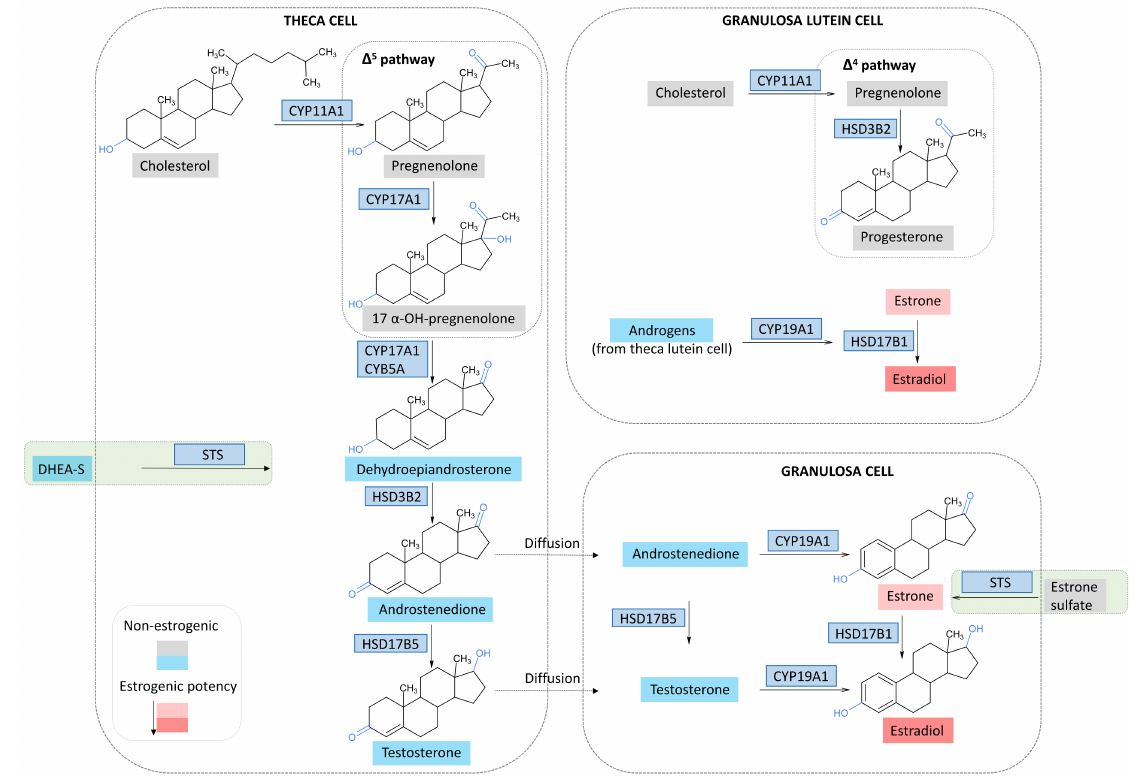
Figure 1. Ovarian steroidogenesis. During a female reproductive age, the thecal and granulosa cells surrounding the developing ovarian follicle and the corpus luteum synthesize progestagens, androgens and estrogens; the ∆ 5 pathway converts pregnenolone to 17- α -pregnenolone, which subsequently gives rise to androgens and estrogens, and is the preferred pathway in thecal cells. The ∆ 4 pathway converts pregnenolone to progesterone, and is the main pathway in the granulosa lutein cells of the corpus luteum; however, estrogen synthesis also occurs. In OC tissue, local estrogen synthesis might take place from circulating androgen (dehydroepiandrosterone sulfate (DHEA-S), dehydroepiandrosterone (DHEA), androstenedione) (left green box) and estrogen precursors (estrone sulfate, estrone) (right green box) via the aromatase and sulfatase pathway, respectively. CYB5A, cytochrome b 5 type A; CYP11A1, cytochrome P450 cholesterol side chain cleavage; CYP17A1, cytochrome P450 17A1; CYP19A1, cytochrome P450 19A1 (aromatase); HSD3B2, 3 β -hydroxysteroid dehydrogenase/ ∆ 4/5 isomerase type 2; HSD17B1, 17 β -hydroxysteroid dehydrogenase type 1; HSD17B5, 17 β